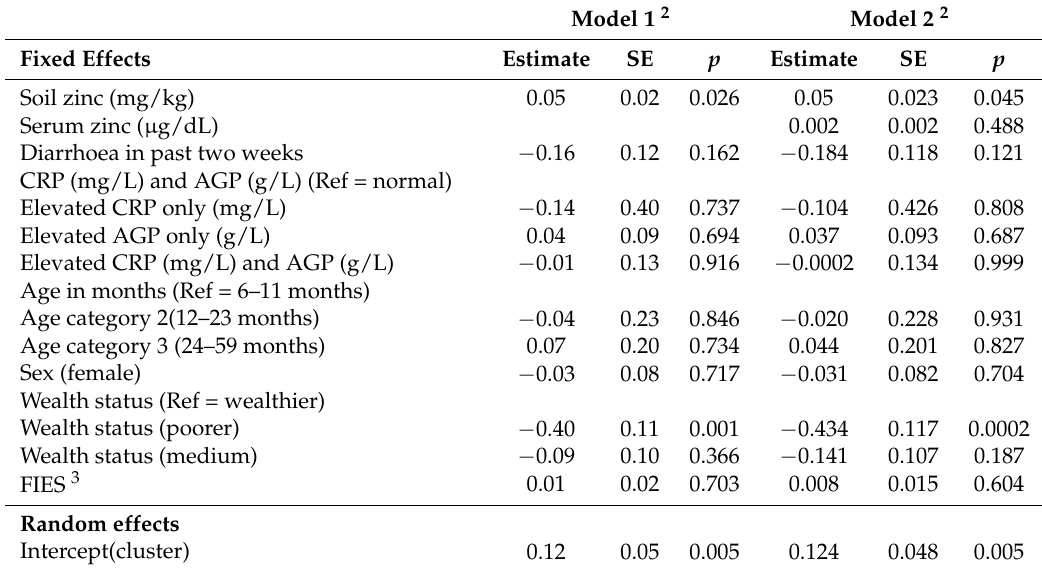
Table 6. Multi-level mixed linear regression models predicting weight-for-height-Z-score 1 ( n =